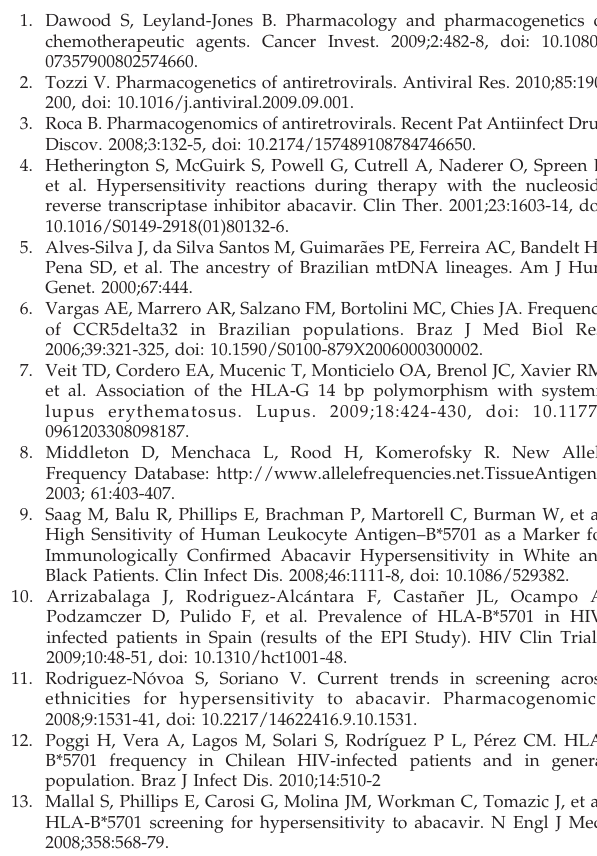
BRA_C: Brazil (Belo Horizonte) Caucasian; HIV_CHI: HIV infected patients from Chile: CHI_P: Chilean general population; CHI_M: Chile (Santiago) Mixed; AUT_C: Austria Caucasian; USA_A: USA (Bethesda) African-American; USA_C: USA (Philadelphia)